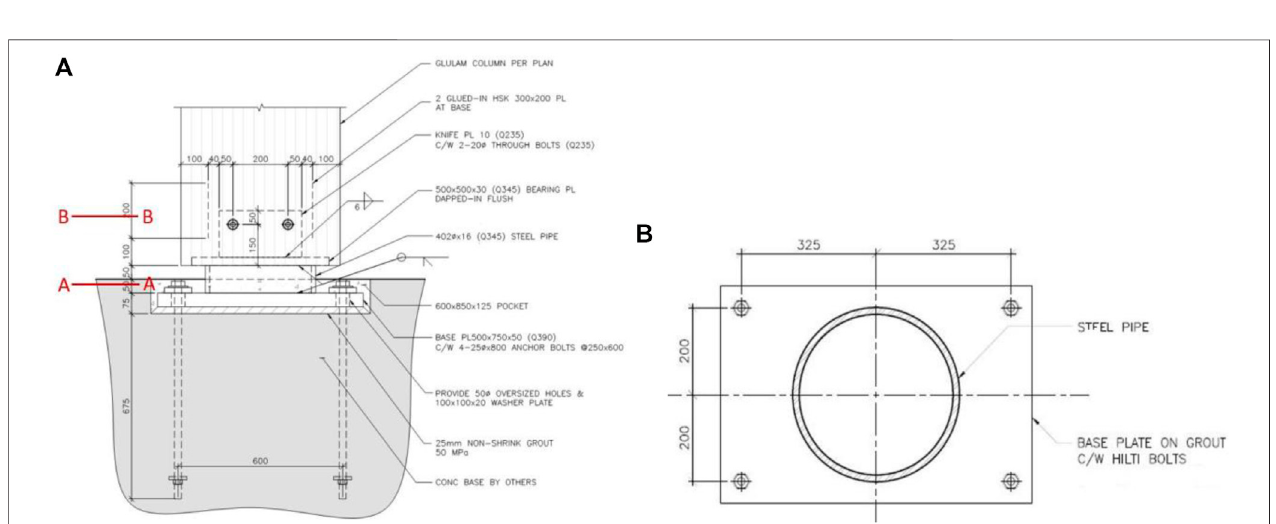
FIGURE 8 | Connection detail for HSK composite glulam column to concrete